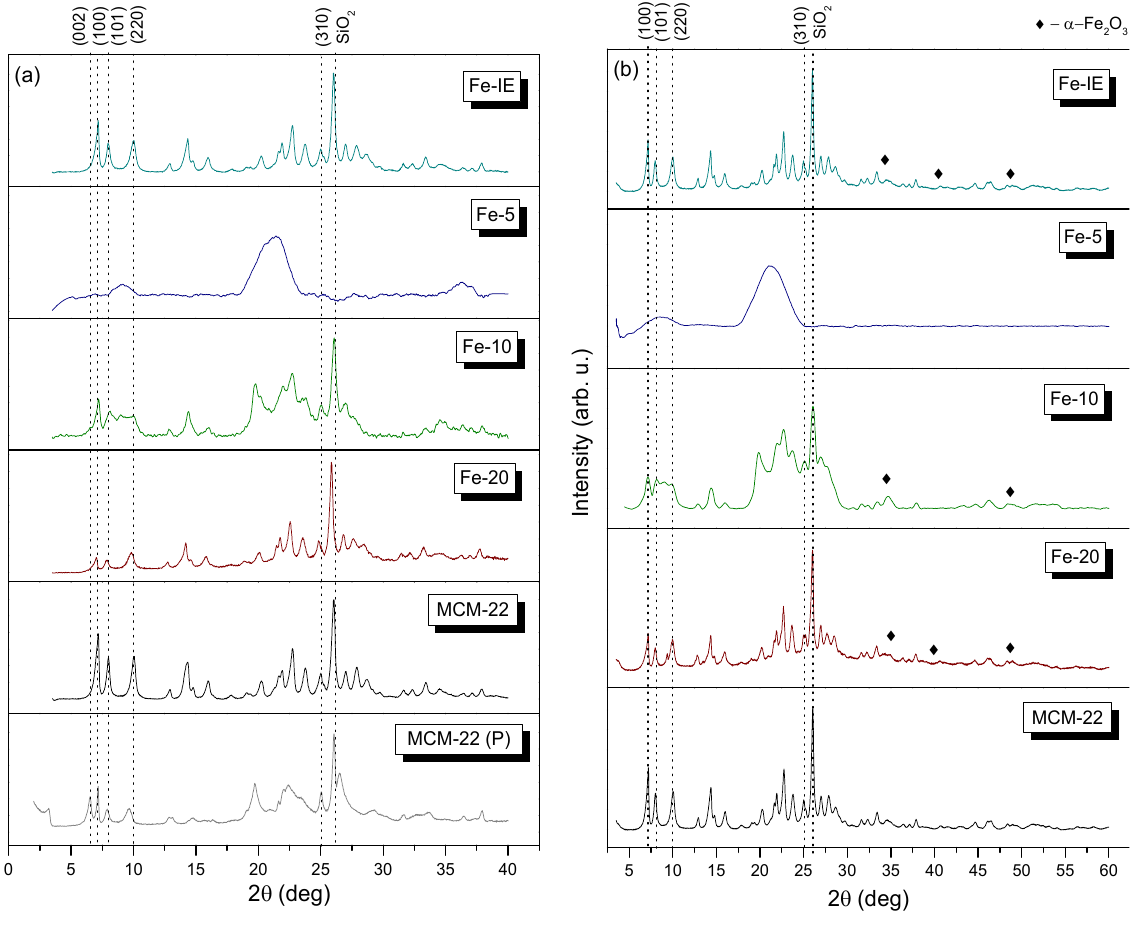
Figure 4. XRD patterns of the zeolites in the 2θ range of ( a ) 3–40° and ( b ) 3–60°.